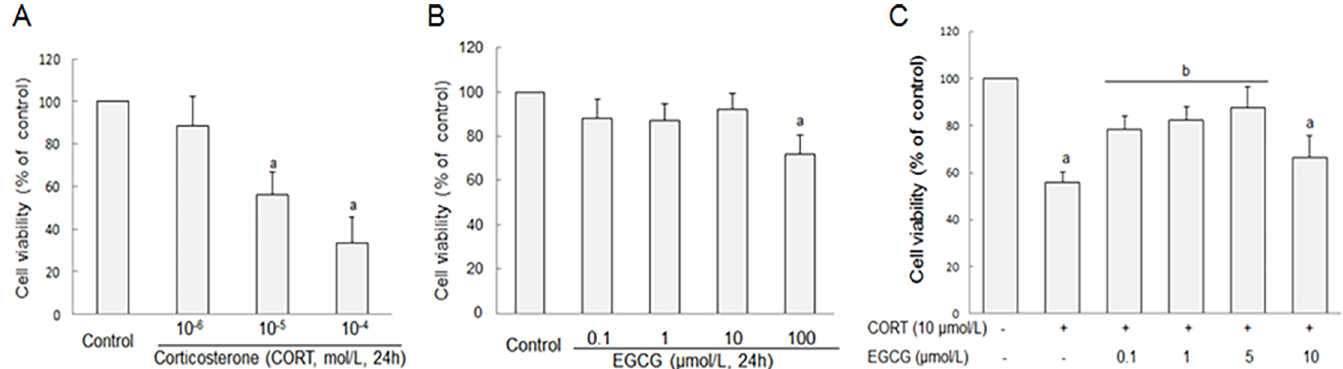
Fig 1. The effect of CORT and EGCG on cell viability of primary hippocampal neuron cultures. Primary cultured hippocampal neurons were treated with various concentrations of CORT for 24 h and cell viability was assessed by MTT (A). Hippocampal neurons were exposed to different concentrations of EGCG for 24 h and cell viability was assessed by MTT (B). Hippocampal neurons were pretreated with different concentrations of EGCG for 30 min before subsequent stimulation with CORT for 24 h (C). a P < 0.05 vs Control group; P < 0.05 vs CORT group.